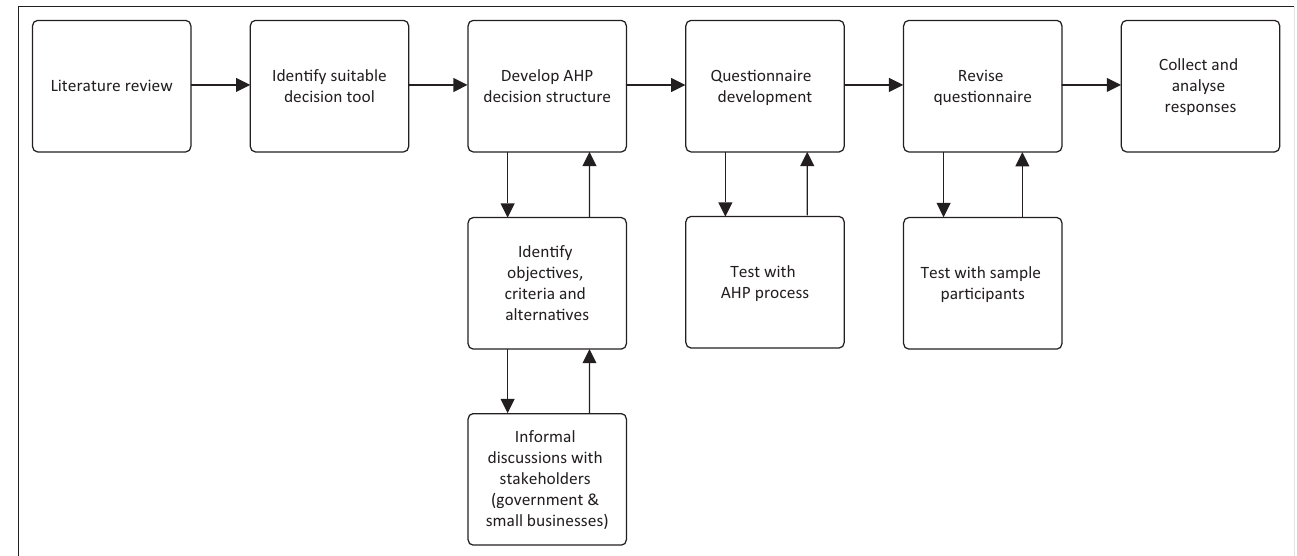
FIGURE 2: The research